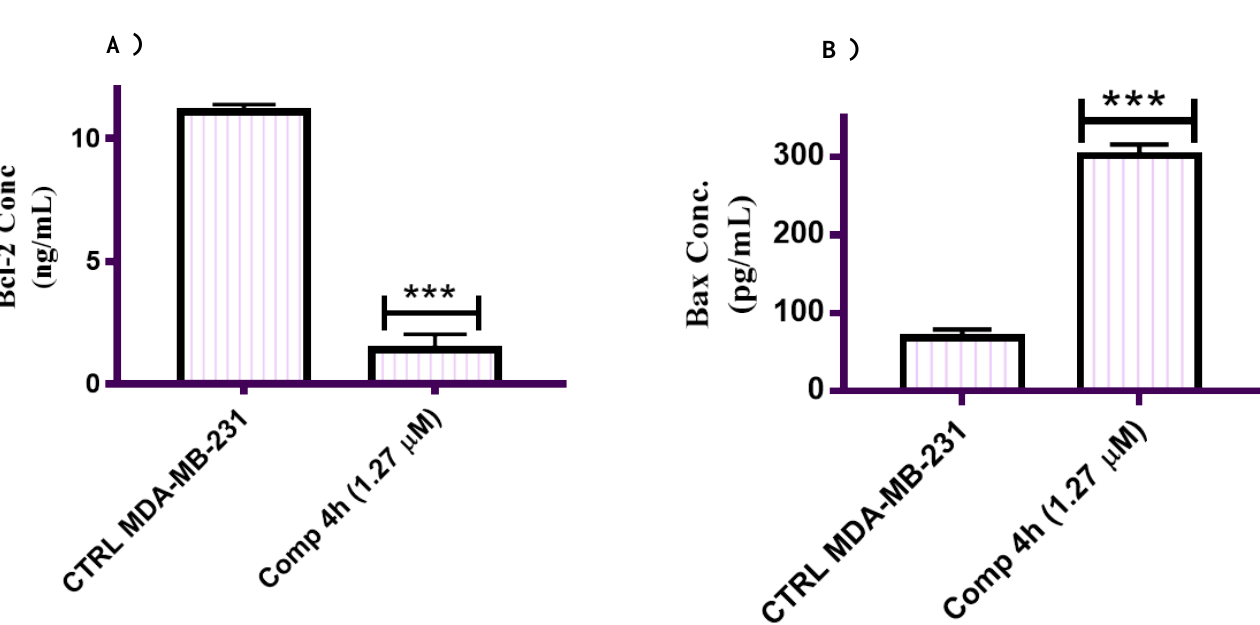
site of 1SA0 by three hydrogen bonds; Asn 101 with the oxygen of trimethoxyphenyl